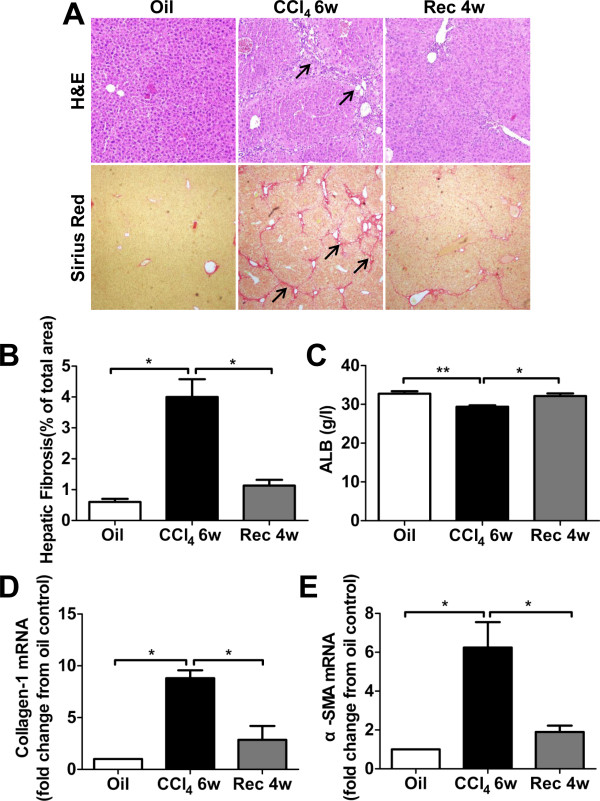
Liver injury induced by CCl4 administration. The mice were repeatedly treated with oil alone or CCl4 mixture for 6 weeks to induce liver injury, and then stopped injection to observe spontaneous recovery for 4 weeks. (A) Liver inflammatory (upper panels arrowhead) and hepatic collagen deposition (lower panels arrowhead) were determined by H&E and Sirius red staining. Original magnifications: upper panels × 100, lower panels × 40. (B) The percentage of stained red area of Sirius red was assessed at 100 × magnification with a quantitative image analyzer. (C) Serum chemistry of liver function was performed for albumin (ALB). The expressions of alpha- smooth muscle actin (SMA) (D) and collagen-1 (E) mRNA in liver tissues were measured by real time (RT)-PCR. CCl4 6w, 6-week CCl4 injection; Rec 4w, stopped CCl4 injection for 4-week to recover spontaneously. *p < 0.05, **p < 0.01.